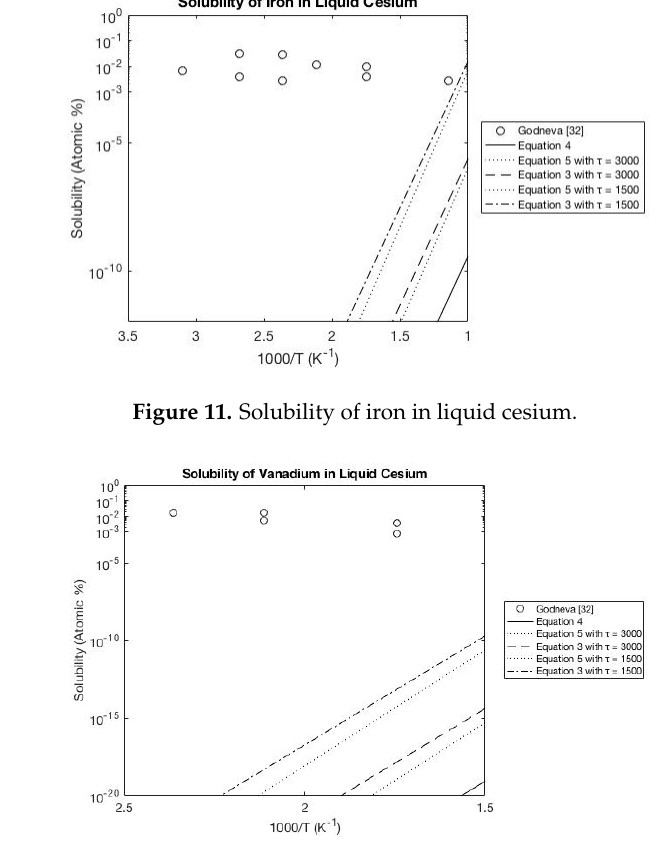
Figure 12. Solubility of vanadium in liquid cesium.